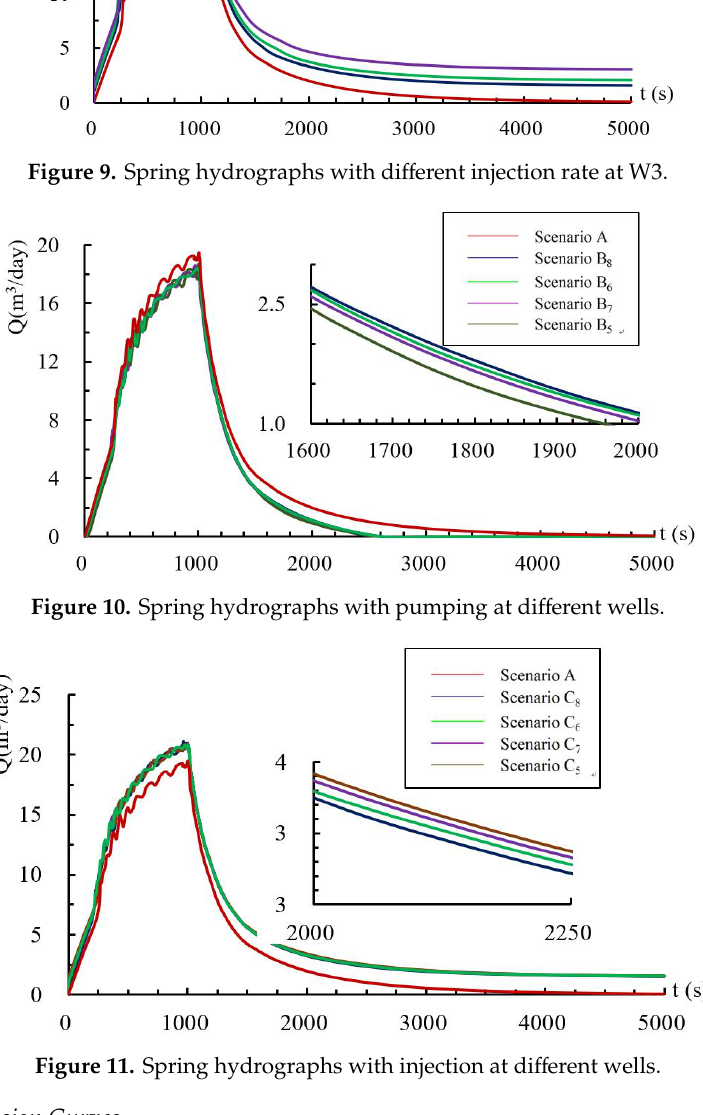
Figure 11. Spring hydrographs with injection at different wells.